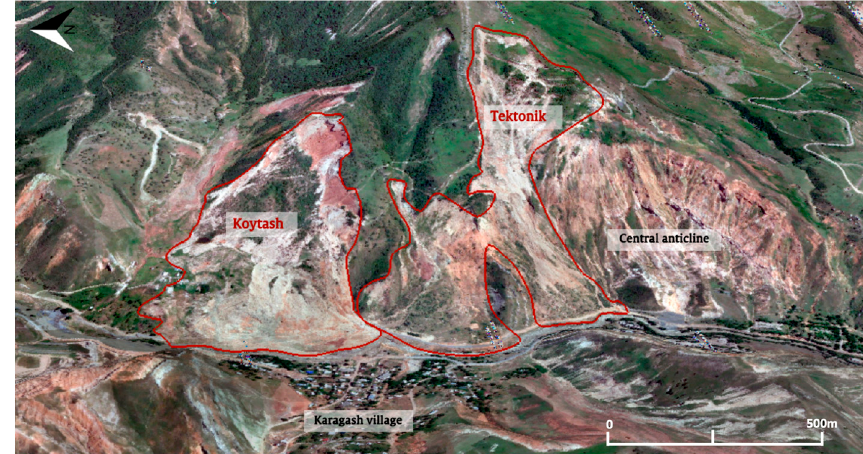
Figure 2. 3D view of the Koytash and Tektonik landslides, produced with ArcScene on the basis of images from the World Imagery (Digital Globe, Google Earth ©). The village of Karagash, part of the larger town of Maily ‐ Say, is located in the foreground, and the central anticline is on the right.